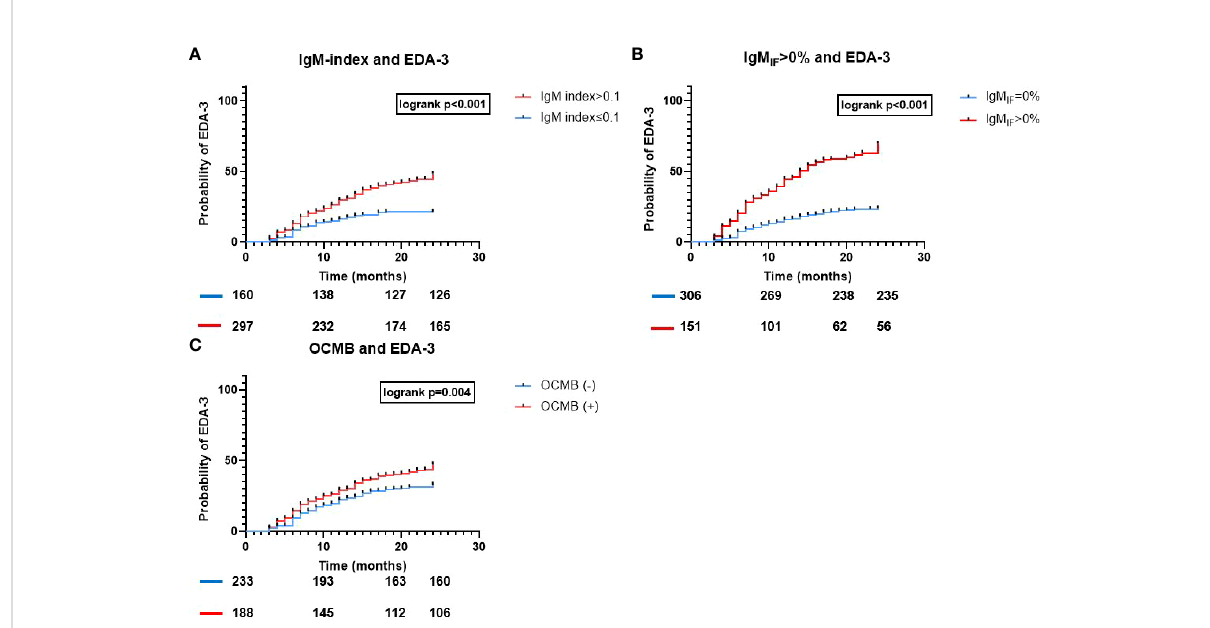
FIGURE 2 Time to EDA-3 for all IgM-metrics used to assess ITMS. Association of ITMS and time to EDA-3. Kaplan-Meier survival curves and results of the logrank test for (A) IgM-index>0.1; (B) IgM IF >0% according to Reiber; and (C) OCMB; and the probability of EDA-3 within 24 months from diagnostic LP; EDA, Evidence of Disease Activity; Ig, immunoglobulin; IF, intrathecal fraction; OCMB, oligoclonal IgM bands.